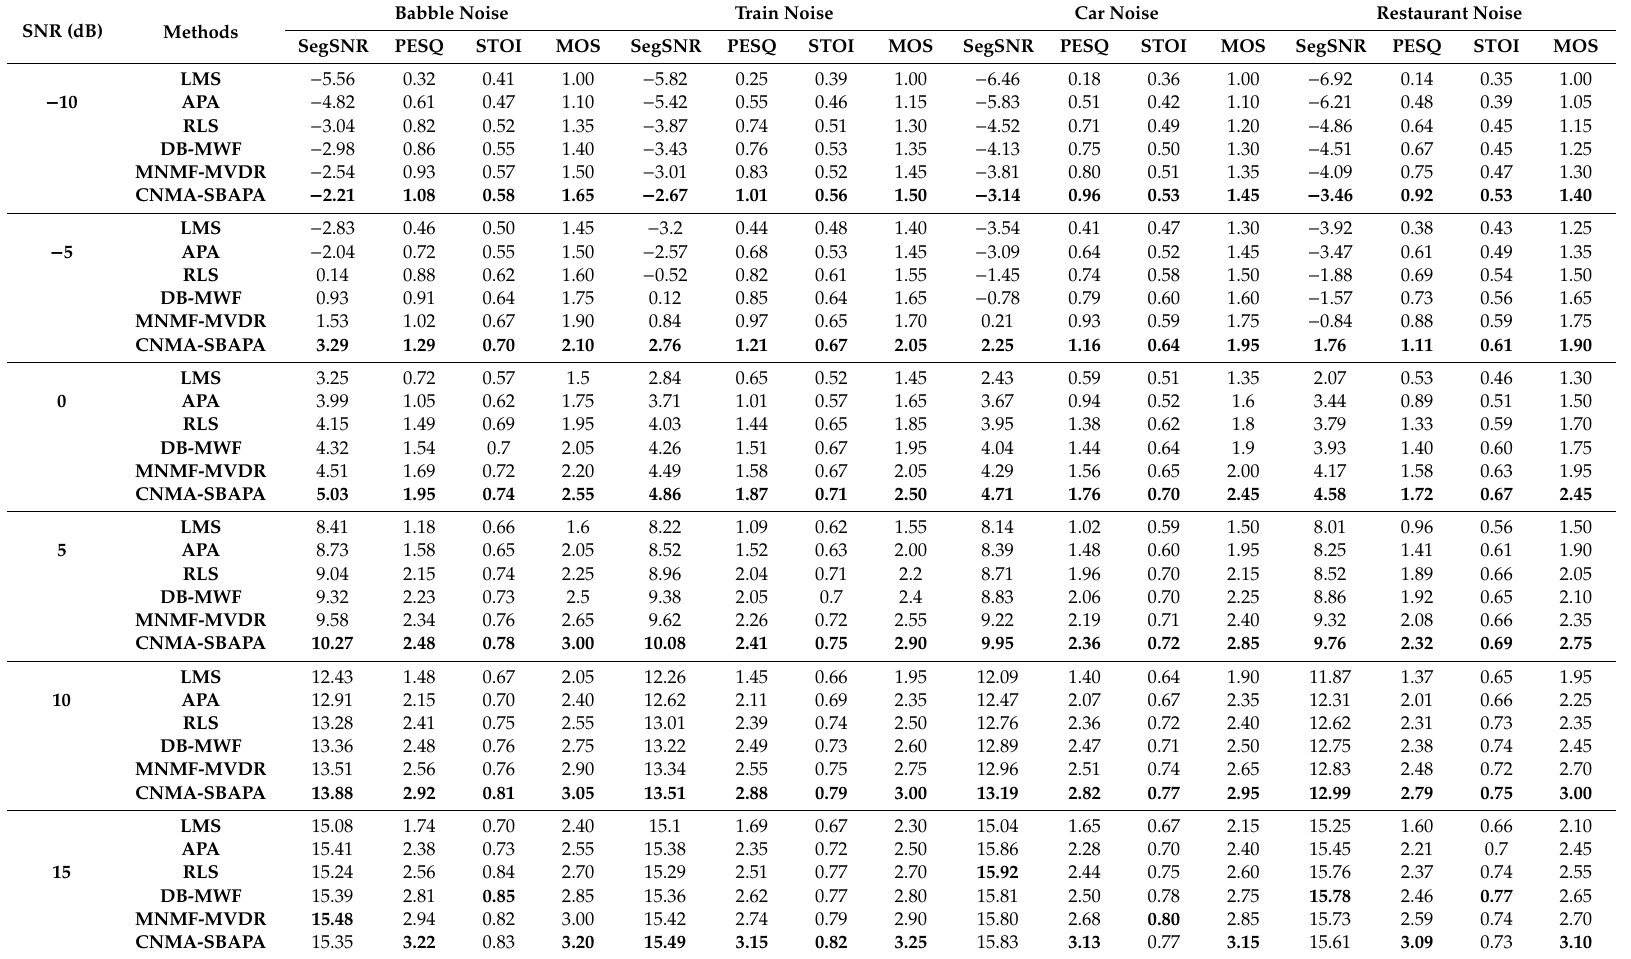
Table 5. The comparison between PESQ, MOS, STOI, and SegSNR for the proposed CNMA-SBAPA in comparison with the LMS, traditional APA, RLS, DB-MWF, and MNMF-MVDR methods on the real data for colored noises such as: train, babble, car, and restaurant noises in di ff erent range of SNRs (the bold numbers are the best